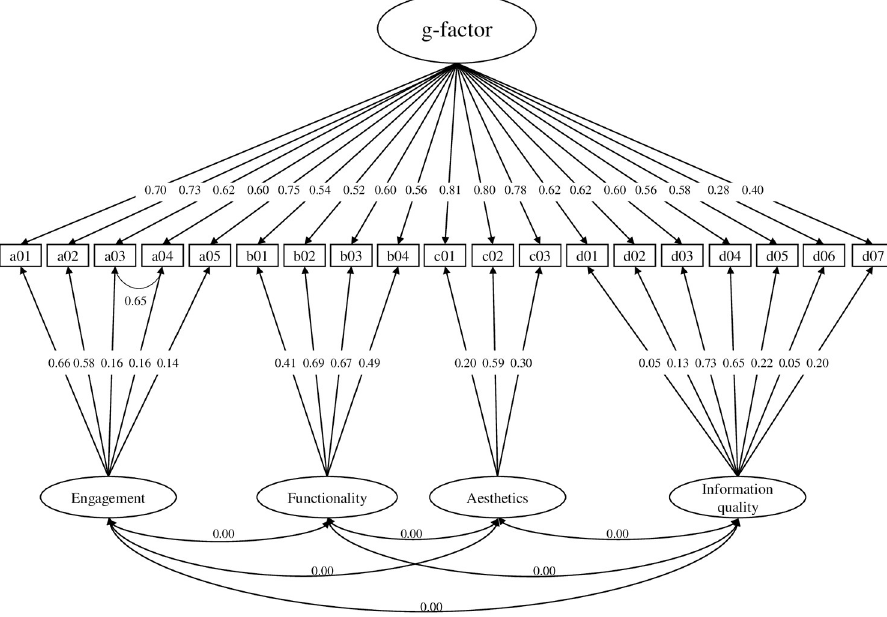
Fig 6. Model 3a. Loadings are standardized; correlations between all latent variables were set to zero; item-wise error variances have been excluded; Model 3a differs from the a-priori defined model 3 in the correlation between item 3 (a03) and item 4 (a04).